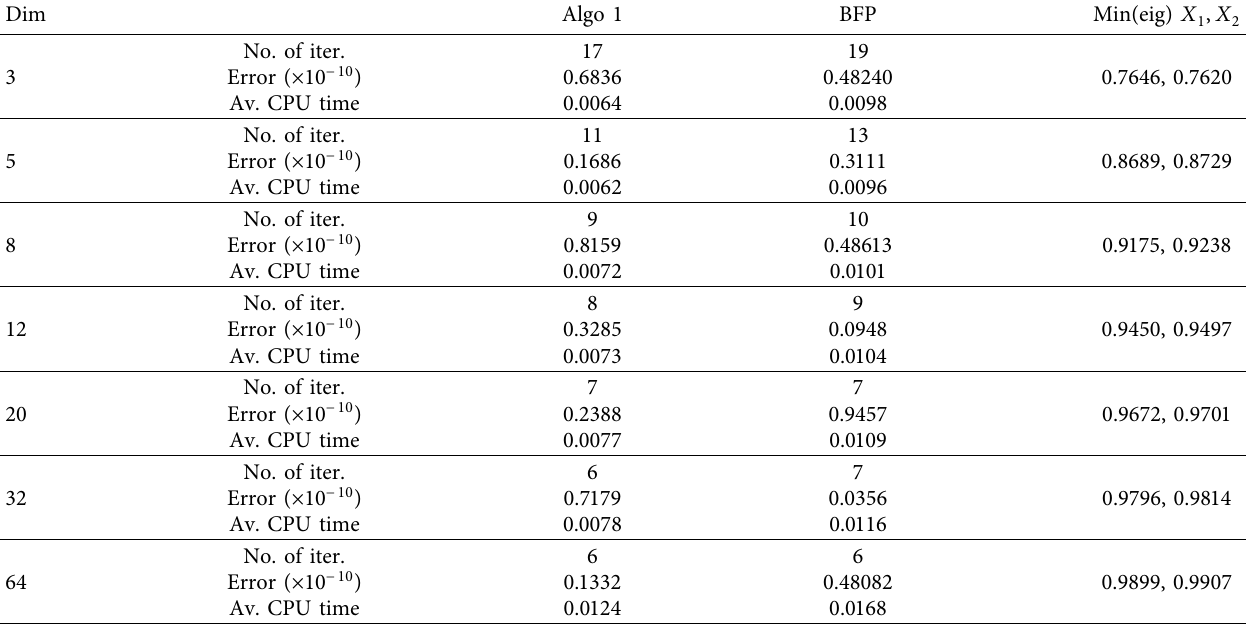
Table 3: Comparison of Algorithm 1 with basic fixed point iteration for different dimension.